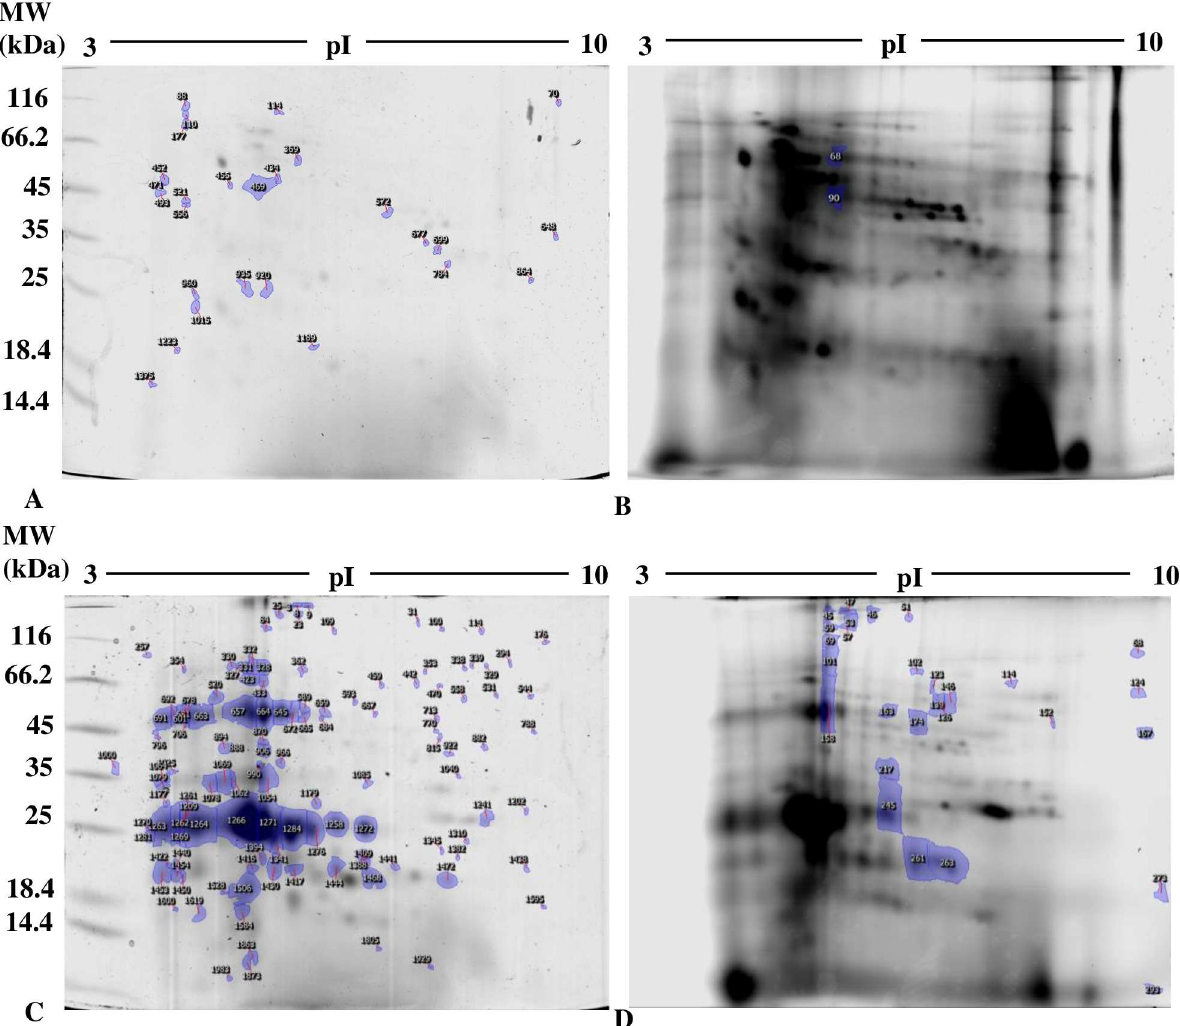
Fig 9. Profiles of the expression of proteins containing carbonyl groups in (A, B) seedlings and (C, D) cotyledons of bean seeds germinated for 9 days in the presenceof distilled water (CTR) or 200 μ M Cu. Proteins(1200 μ g) were labeledwith FTSC and separated by 2-D SDS-PAGE. Figures show spots of interest in representative gels from (A) colloidalCoomassie BrilliantG-250 staining (scannedwith GS-800 calibrated densitometer) and (B) FTSC labeling(scannedwith Typhoon9400 scanner; 600 PMT). Numbers correspond to spots of p < 0.05and Fold induction > 1.5 (spots